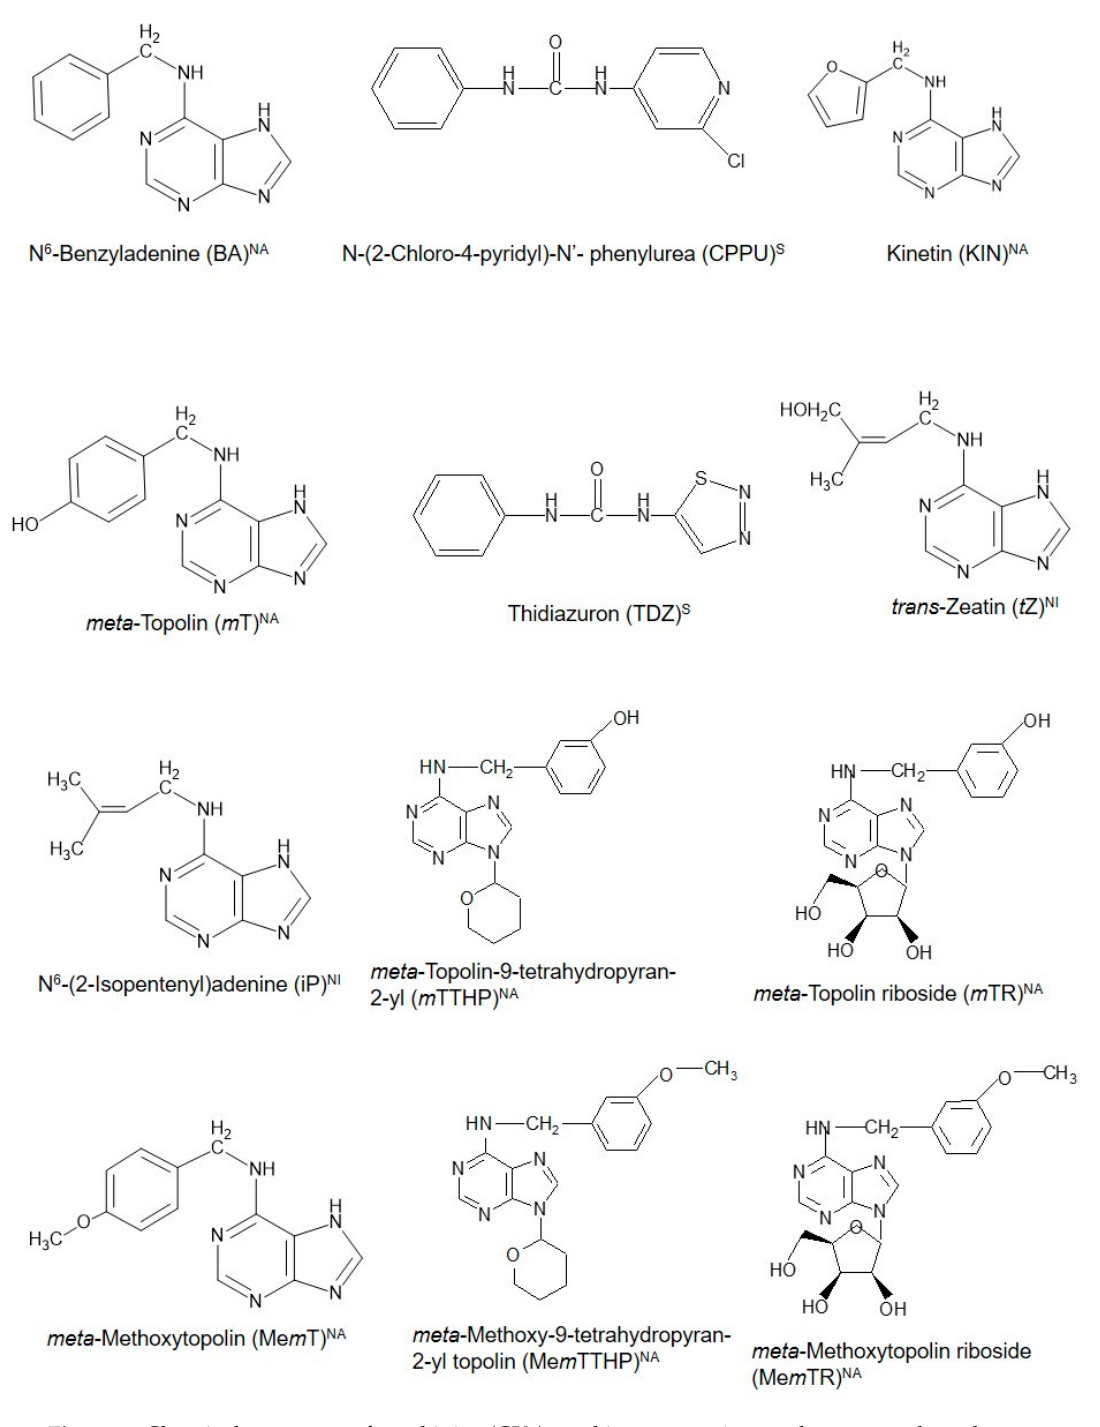
Figure 1. Chemical structures of cytokinins (CKs) used in propagation, preharvest, and postharvest stages during the production of some common horticultural fruit crops. NA = natural aromatic CK; NI = natural isoprenoid CK, and S = synthetic CK.